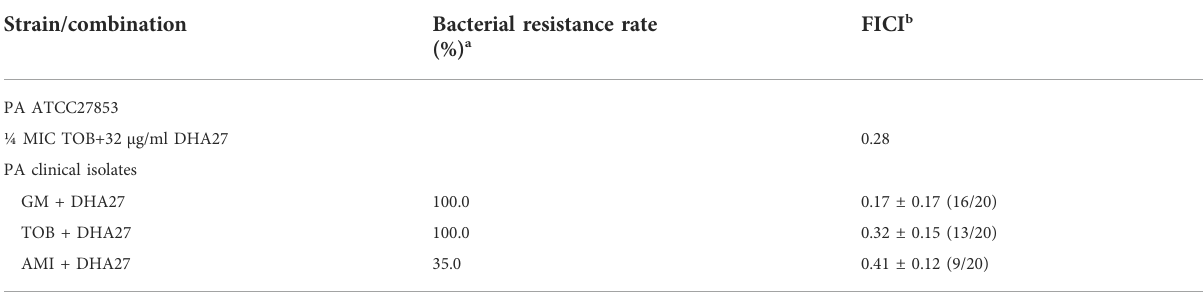
TABLE 3 Fractional inhibitory concentration index (FICI) values for DHA27 in combination with aminoglycosides against Pseudomonas aeruginosa (PA) ATCC27853 and 20 clinical isolates of